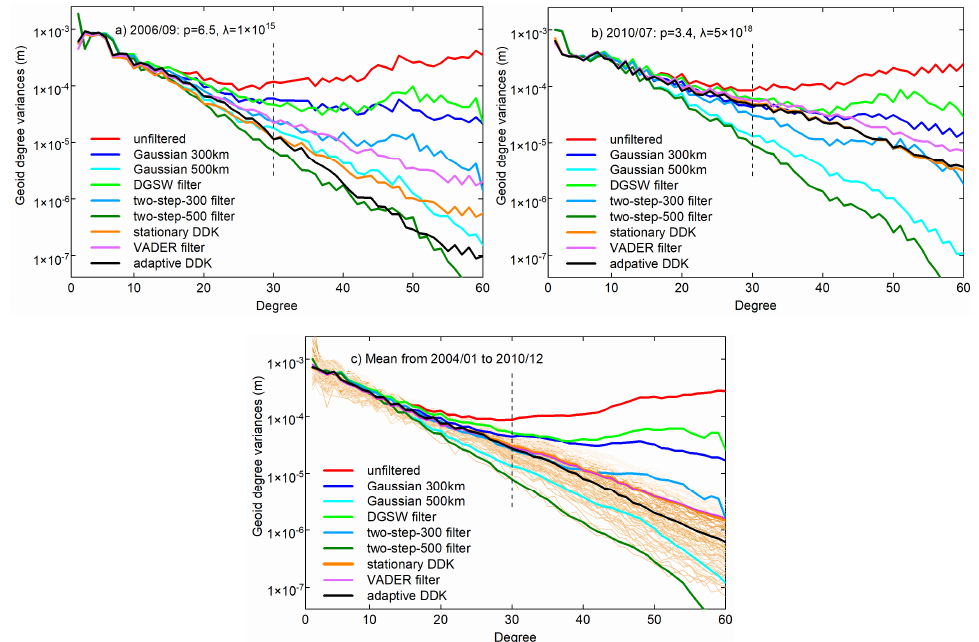
Figure 11. The geoid degree variances of filtered solutions for ( a ) September 2006, ( b ) July 2010, and ( c ) the 7-year means from January 2004 to December 2010. The cluster of brown curves represents the monthly geoid degree variances of the adaptive DDK filtered solution. The vertical dashed line, corresponding to degree 30, is shown to help compare the signal level (the first 30 degree) and noise level (the last 30 degrees) in the filtering solution intuitively.